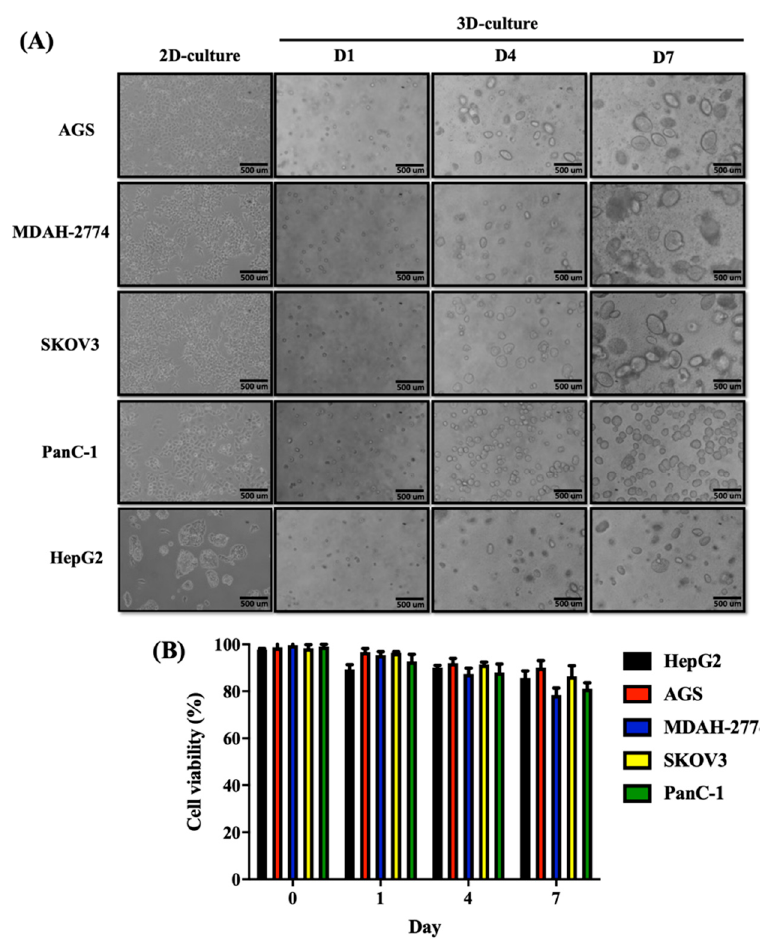
Figure 2. Spheroid formation and cell viability of cancer cell lines cultured using the ACD 3D culture system. ( A ) Five different cancer cell lines, AGS, MDAH-2774, SKOV3, PanC-1, and HepG2 cells were cultured for 3 days in 2D culture. Bright-field images show the morphologies of cells in adherent culture. AGS, MDAH-2774, SKOV3, PanC-1, and HepG2 cells can form spheroids when 3000 cells are seeded into 24-well plates within 4 days after incubation in the ACD 3D culture system. Bright-field images show the morphologies of spheroids on Days 1, 4, and 7 in the ACD 3D culture system. On Day 7, AGS, MDAH-2774, and SKOV3 cells formed large, ellipsoid spheroids, whereas HepG2 cells formed small, ellipsoid spheroids and PanC-1 cells formed small, round spheroids. Images were captured using phase-contrast microscopy on Days 1, 4, and 7. Scale bar = 500 μ m. ( B ) Spheroids were collected on Days 1, 4, and 7. After resuspension of spheroids to obtain single-cell suspensions, cell viability was evaluated by 0.2% trypan blue. Cells obtained from AGS, MDAH-2774, PanC-1, and HepG2 spheroids exhibited greater than 80% viability on Days 1 and 4. On Day 7, the cell viabilities of AGS, MDAH-2774, PanC-1, and HepG2 cells were greater than 70%. Data shown as mean ± SD of triplicate independent